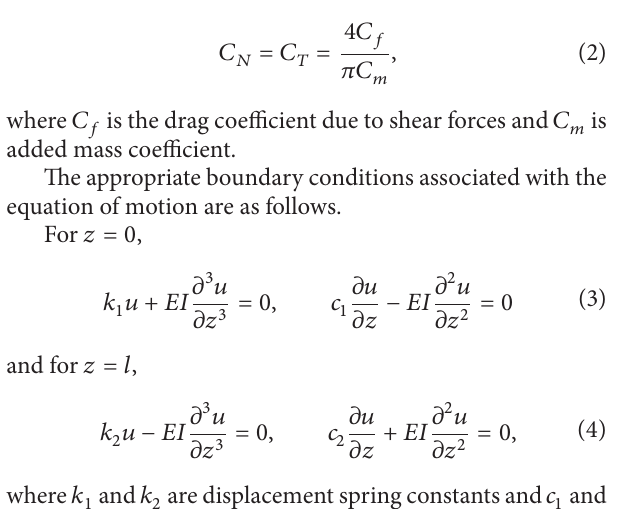
Figure 4: Schematic diagram of experimental loop.